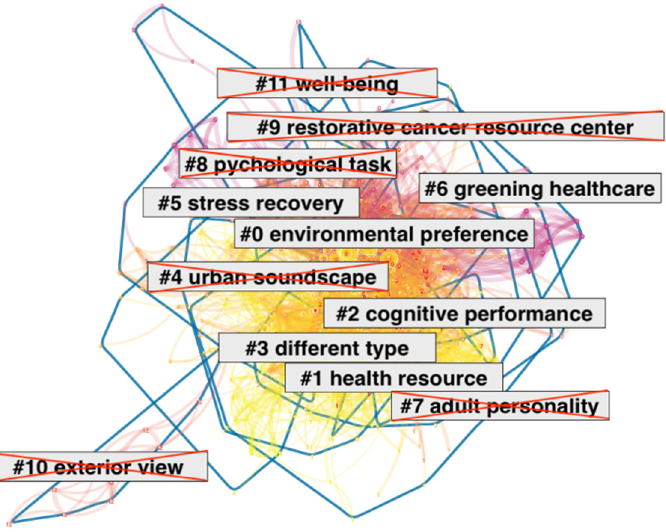
Figure 4. Co-citation clusters of the network for the first step of the review, restoration